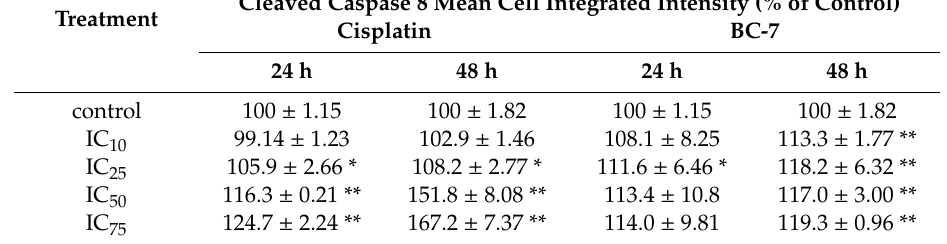
Table 5. Changes in cleaved caspase 8 levels in HeLa cells after 24 and 48 h of exposure to cisplatin and BC-7.